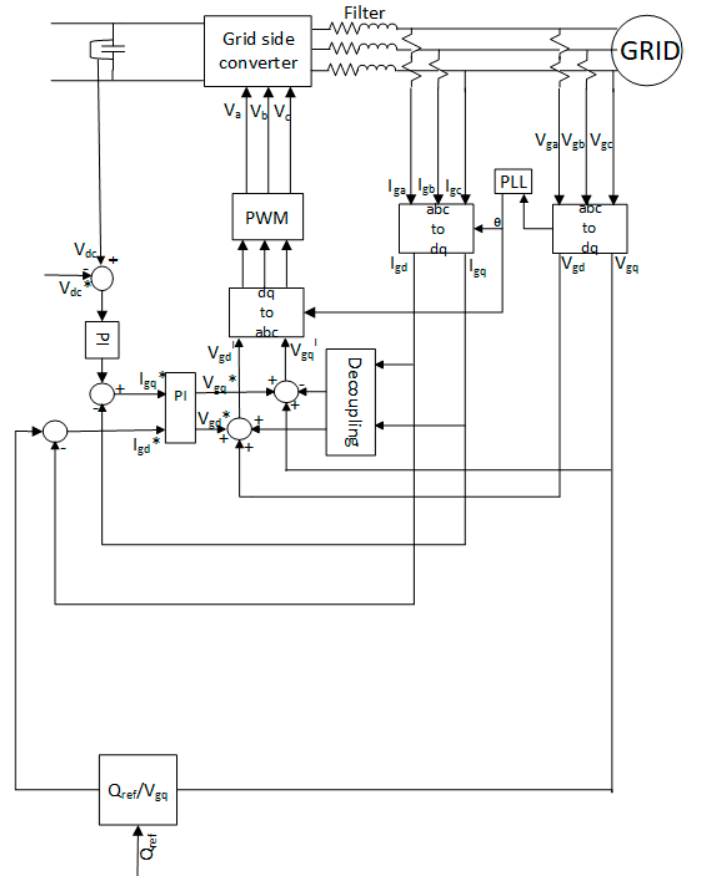
Figure 5. Control of the grid side converter of the DFIG, including PI controllers, low pass filter, PLL and filter.